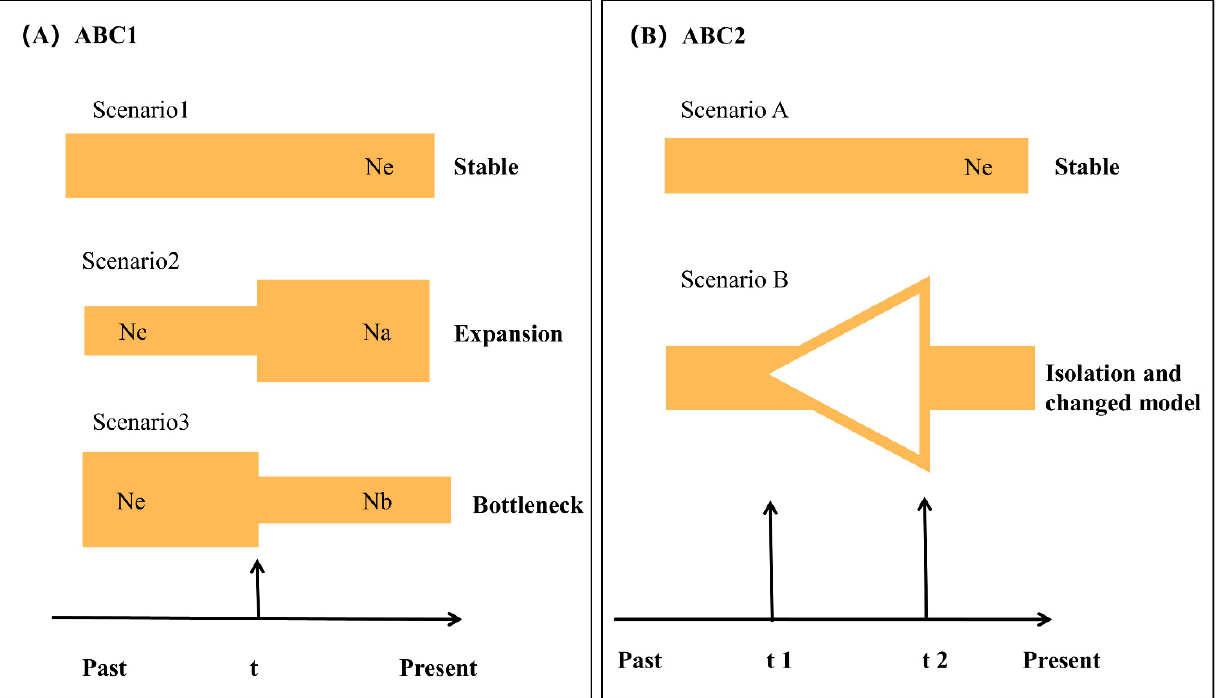
Figure 2. Schematic representation of five demographic scenarios for O. hainanensis tested by approximate Bayesian computation (ABC). Time and effective population size are not to scale. ( A ) Graphical representation of the three scenarios in ABC 1 analysis; ( B ) Graphical representation of the two scenarios in ABC 2 analysis.